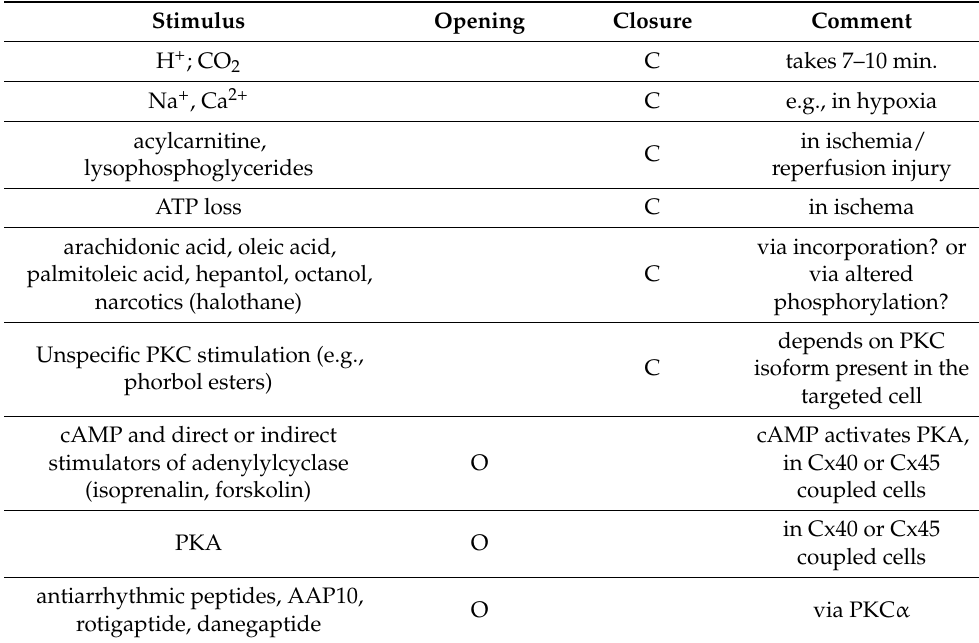
Table 1. Stimuli affecting acute macroscopic gap junction conductance (C = closure; O = opening or increase in conductance; other abbr.: see